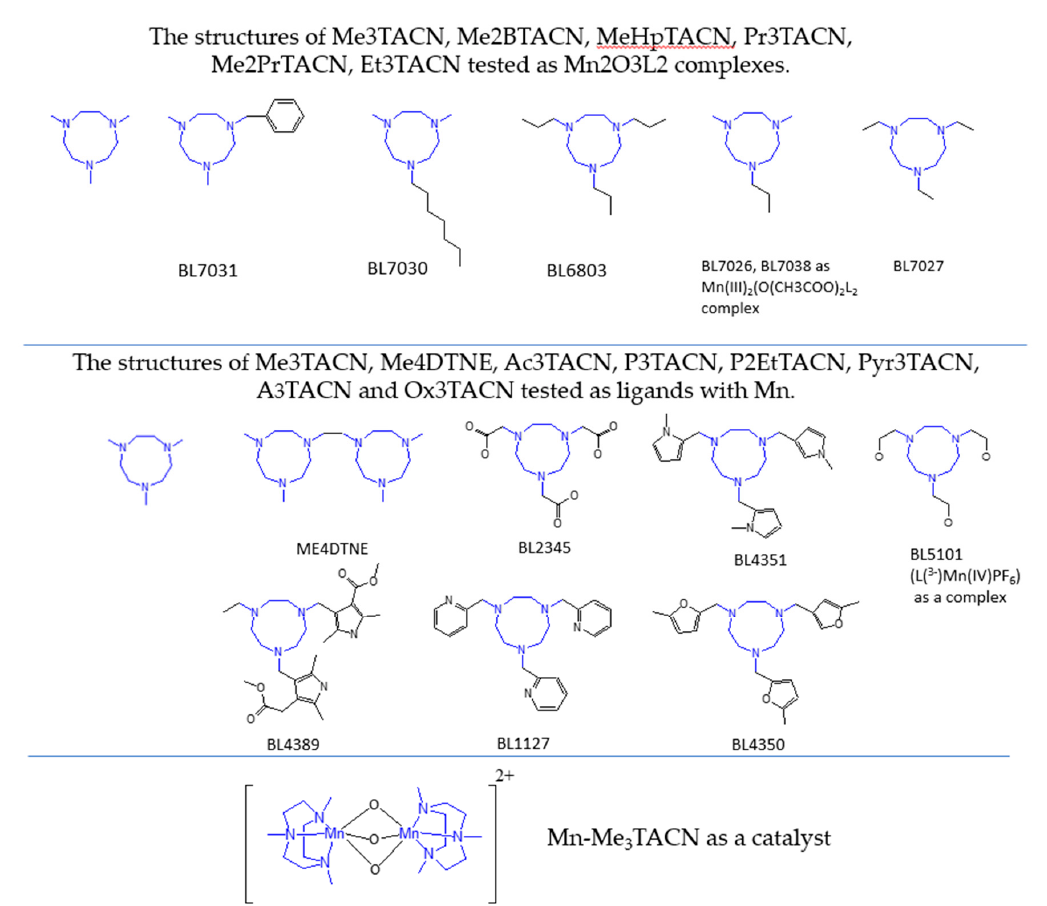
Figure 10. Schematic structures of the ligands tested as [Mn 2 O 3 L 2 ] 2 + complexes (top) or tested as mixtures with Mn II (EH) 2 (middle). At the bottom of the figure, the structure of the dinuclear [Mn 2 O 3 L 2 ] 2 + complex with L = Me 3 TACN is depicted. The codes given are numbers as used for the ligands and complexes and are also used in the results shown in Figures 11–13.